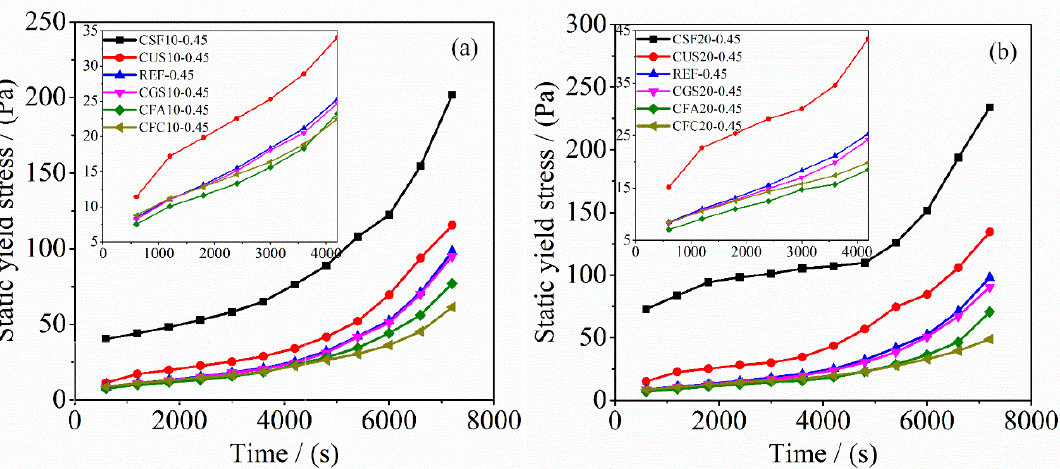
Figure 7. Effect of different mineral admixtures on the evolution of static yield stress of common pastes: ( a ) containing 10% of mineral admixture, ( b ) containing 20% of mineral admixture. The wet packing density of each paste was tested, and its water film thickness was then calculated, as shown in Figure 8. The average distance between particles can be characterized by the water film thickness.